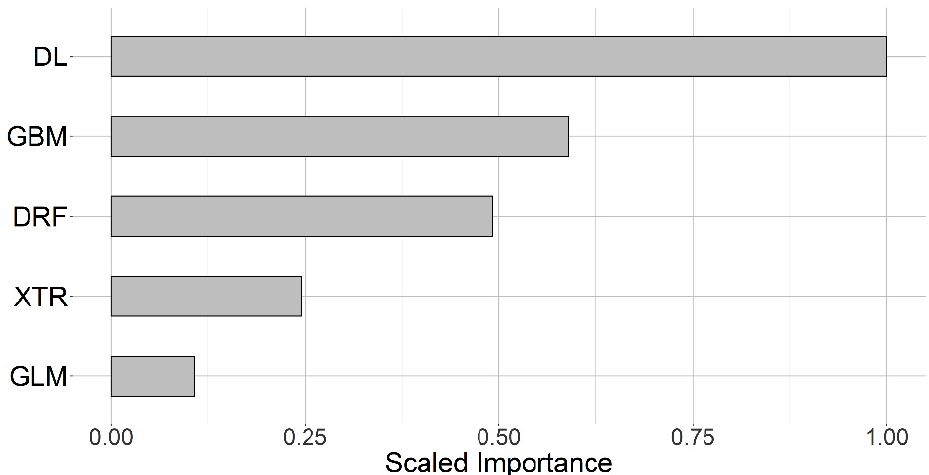
Figure 6. Contribution of base learners to SEfamily built with GLM meta-learner and scaled importance between 0 and 1. The importance ranking is based on a standardized coefficient, which is the predictor weight of the standardized data. DL: Deep learning, DRF: Distributed Random Forest, GBM: Gradient Boosting Machine, GLM: Generalised Linear Model, SE: Stacked Ensembles, XRT: Extremely Randomized Trees.